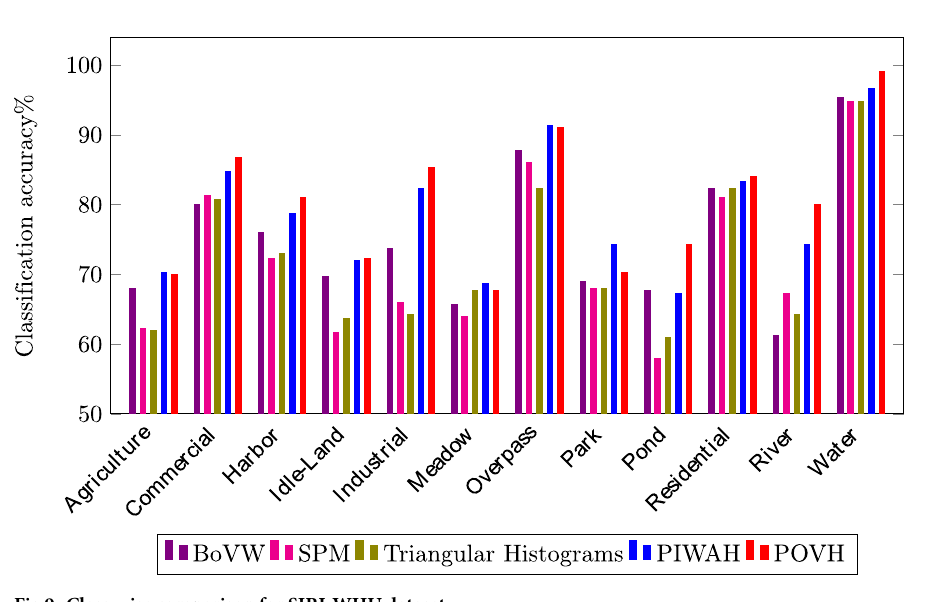
Fig 9. Class-wise comparison for SIRI-WHU dataset.